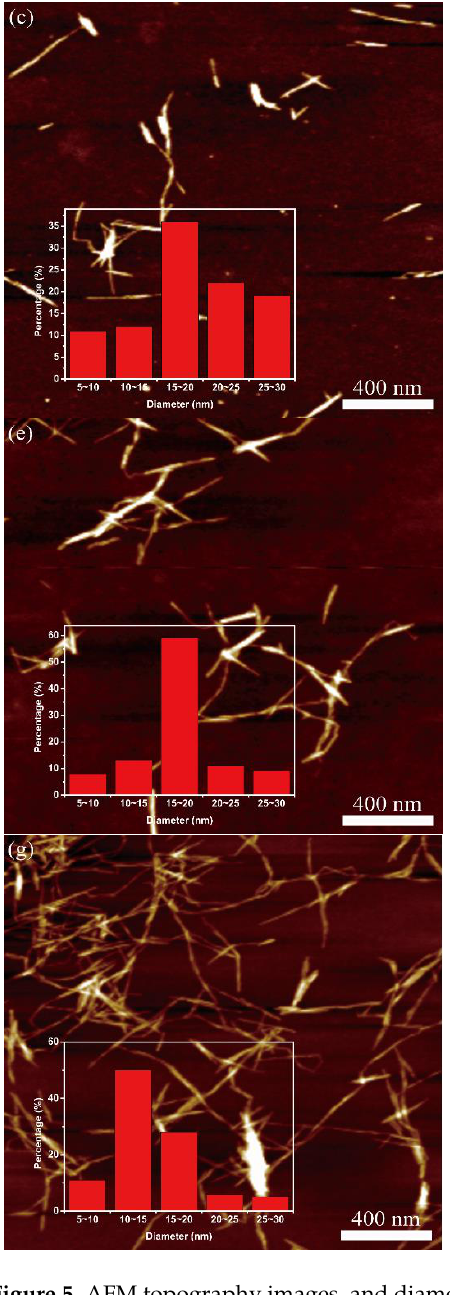
Figure 5. AFM topography images, and diameter distribution histograms of ( a ) CNF, ( b ) CNF-6-1, ( c ) CNF-6-1.5, ( d ) CNF-9-1, ( e ) CNF-9-1.5, ( f ) CNF-12-1, and ( g ) CNF-12-1.5.